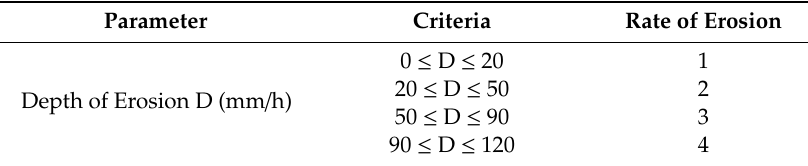
Table 4. Erodibility indices.